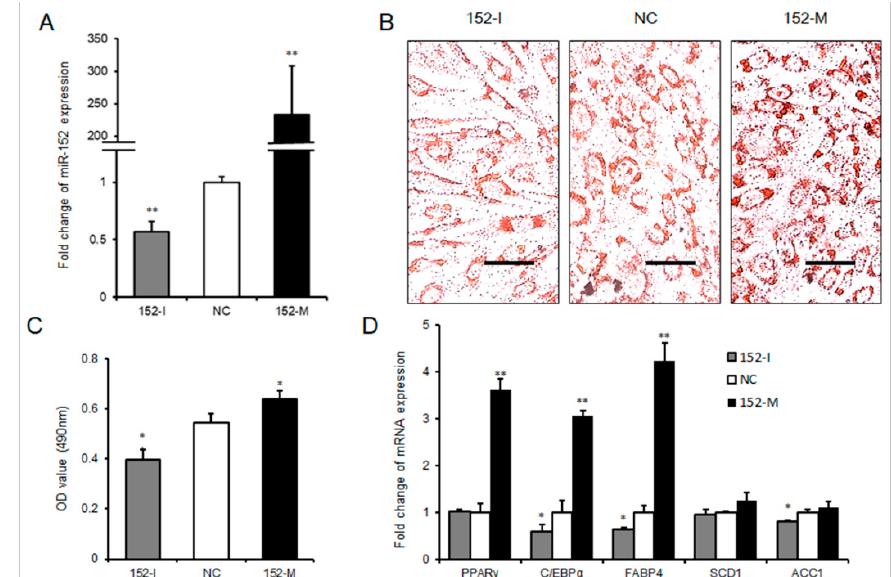
Figure 3. miR-152 promotes 3T3-L1 preadipocyte differentiation. ( A ) The efficiency of miR-152 overexpression and knockdown during 3T3-L1 cell differentiation. ( B ) Intracellular lipid accumulation was measured by Oil Red O Staining on day eight after adipogenic induction. ( C ) The contents of triglycerides in terminally differentiated adipocytes. ( D ) The mRNA expression levels of PPAR γ , C/EBP α , FABP4, SCD1, and ACC1 were detected by qRT-PCR after 3T3-L1 cells transfected with the miR-152 mimic, the miR-152 inhibitor or the negative control on day eight; Results are presented as means ± SD. n = 3. * p < 0.05; ** p < 0.01. Scale = 100 μ m.